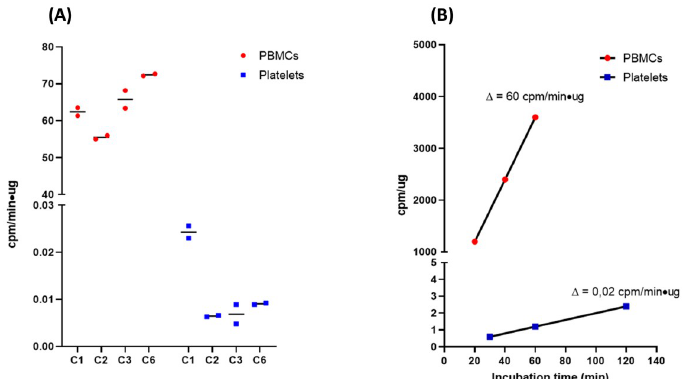
Fig 2. Comparison between rate of protein synthesis measured in PBMCs and platelets. (A) Rate of protein synthesis were compared between PBMCs and platelets of 4 control individuals. Rate of protein synthesis measurement in PBMCs is greater (3 order of magnitude) than in platelets. (B) Typical result obtained from a control PBMCs and platelets. All results were normalised according to protein quantification to ensure correct comparison between both cell types.